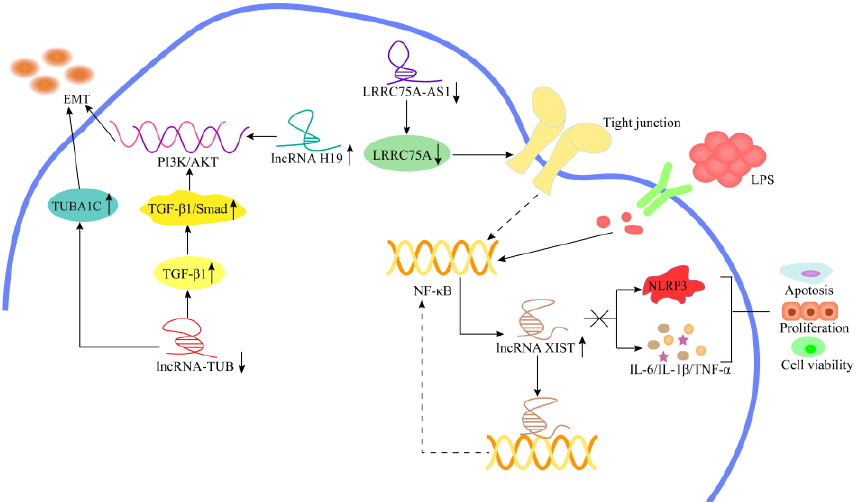
Figure 8. Mechanism of lncRNAs in the modulation of mastitis. Overexpression of lncRNA H19 promotes TGF- β 1-induced EMT via PI3K/AKT signaling pathway. Knockdown of lncRNA-TUB results in the downregulation of TUBA1C and the upregulation of TGF- β 1, and the increased secretion of TGF- β 1 activates the TGF- β 1/Smad pathway, ultimately promoting EMT. LncRNA XIST mediates cell proliferation, viability, and apoptosis via generating a negative feedback regulation of NF- κ B/NLRP3 inflammasome pathway. Downregulated LRRC75A-AS1 inhibits the NF- κ B pathway by enhancing the expression of TJ protein, thereby alleviating the inflammatory response of MAC-T cells.